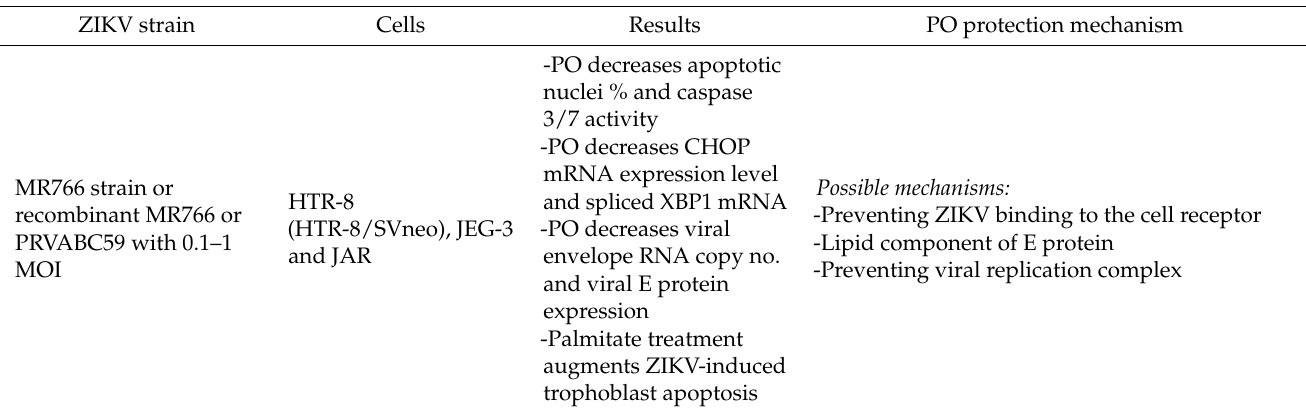
ZIKV infection induces ER stress and apoptosis in placental trophoblast.